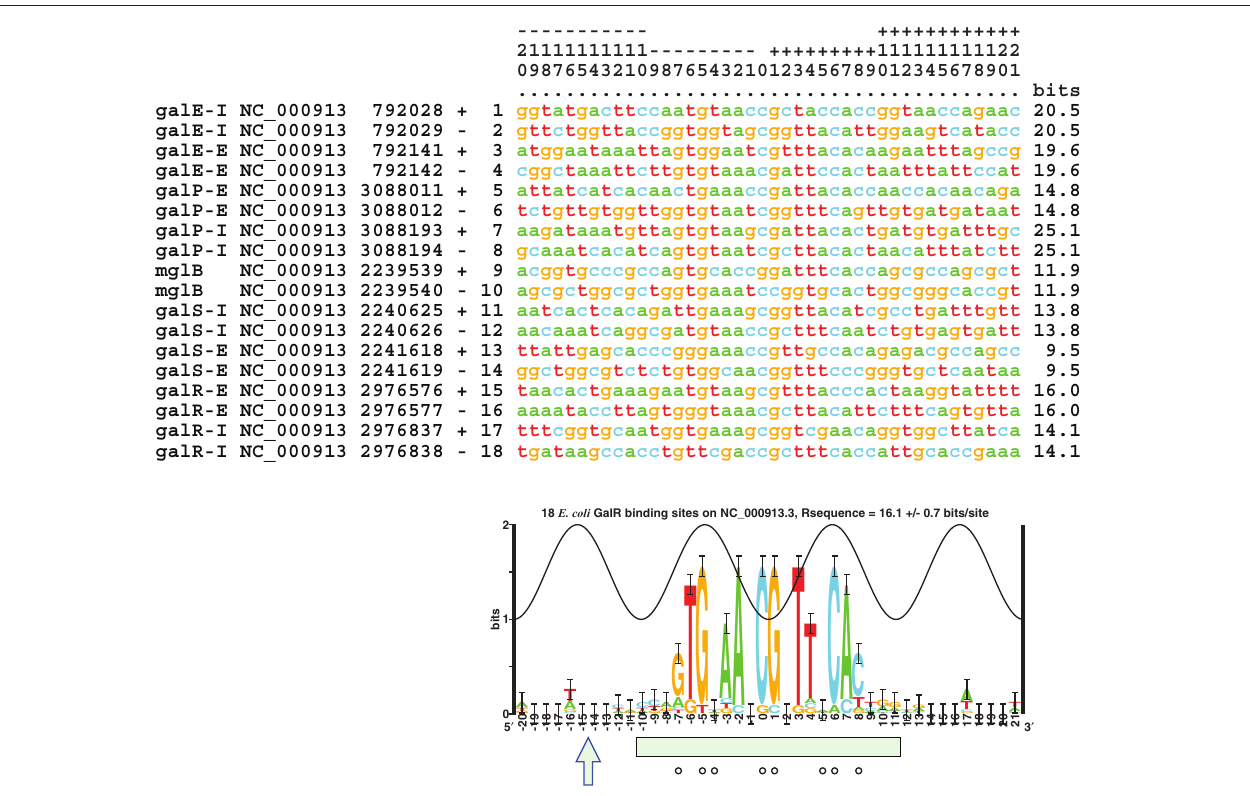
FIGURE 4 | Sequence alignment of 9 studied GalR binding sites (NC_000913.3) and corresponding sequence logo (Schneider and Stephens, 1990). The numbers on the top are to be read vertically. The peak of the sine wave indicates the location where the major groove of the DNA faces GalR (Papp et al., 1993). The information content of each site is indicated in the right hand column, they average to the area under the sequence logo, 16.1 ± 0.7 bits/site ( Schneider et al., 1986; Schneider, 1997). A DNase I-hypersensitive site is indicated by an arrow and DNase I protection by a green box (Majumdar and Adhya, 1987). Bases protected from DMS by GalR are shown by circles (Majumdar and Adhya, 1989). The aligned listing and logo were created using Delila programs (Schneider et al., 1982, 1984). In this logo, base pair 9 in the consensus sequence mentioned elsewhere is marked as